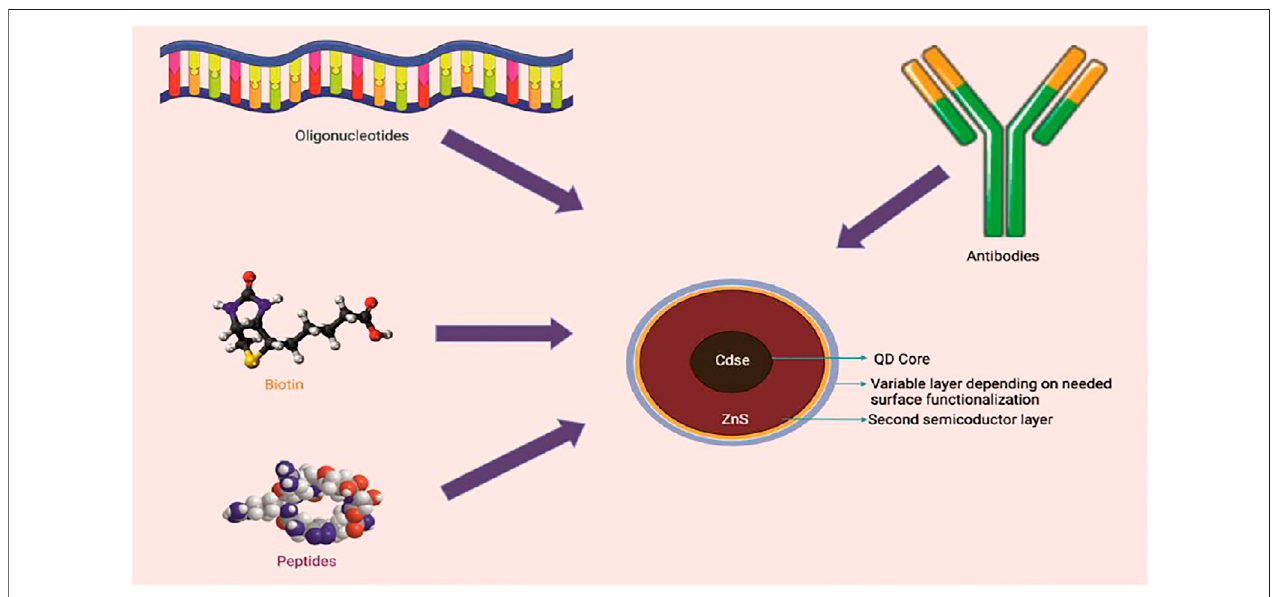
FIGURE 1 | Schematic representation of simple Quantum dot